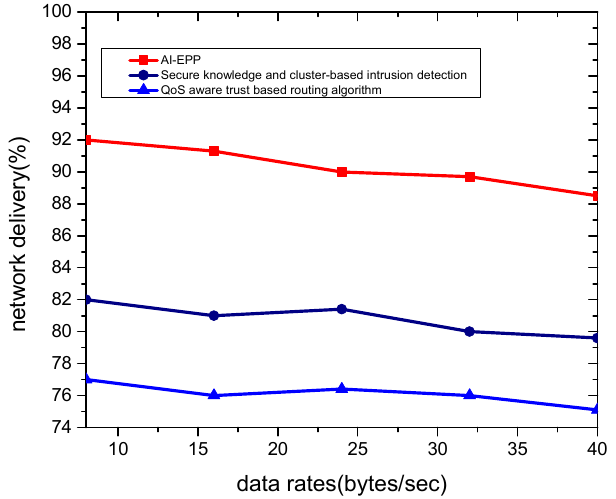
Figure 4. Network delivery comparison using simulations with varying data rates.